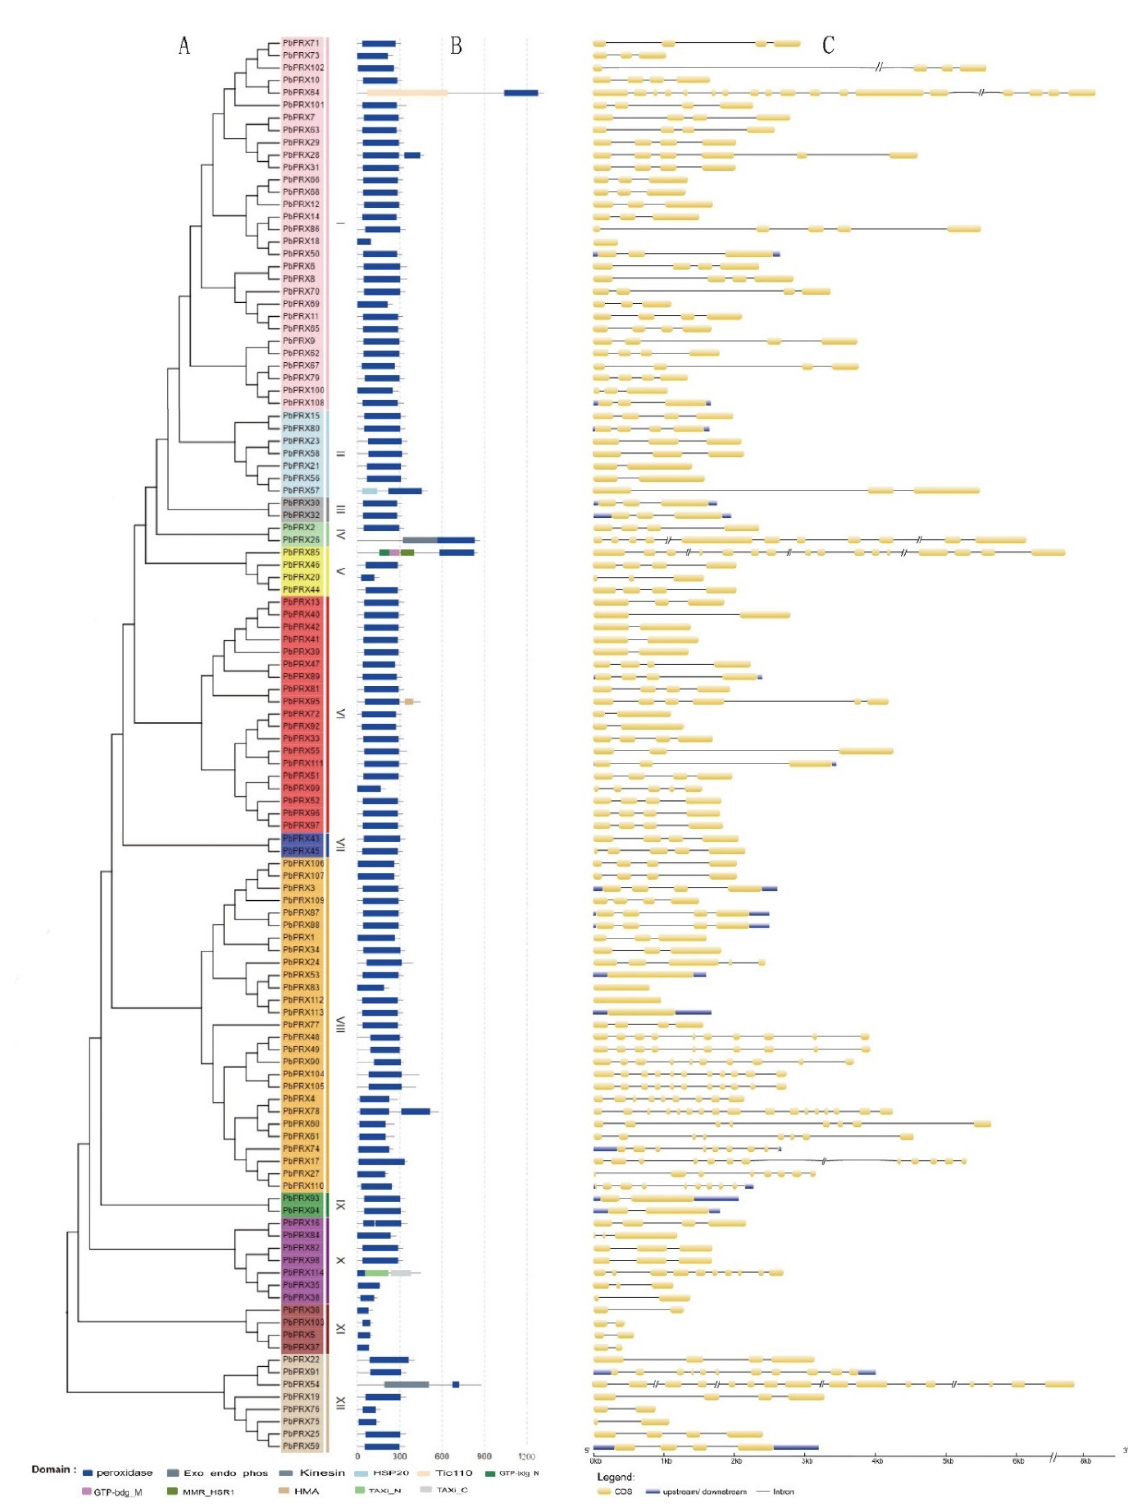
Figure 1. Phylogenetic relation, domain, and gene structure of PbPRX gene family. ( A ) Phylogenetic tree of the PbPRX gene family. ( B ) Domain information of members of PbPRX gene family; ( C ) Exon–intron structure of pear PRX genes. Yellow boxes indicate exons; lines indicate introns; blue boxes indicate the upstream or downstream.